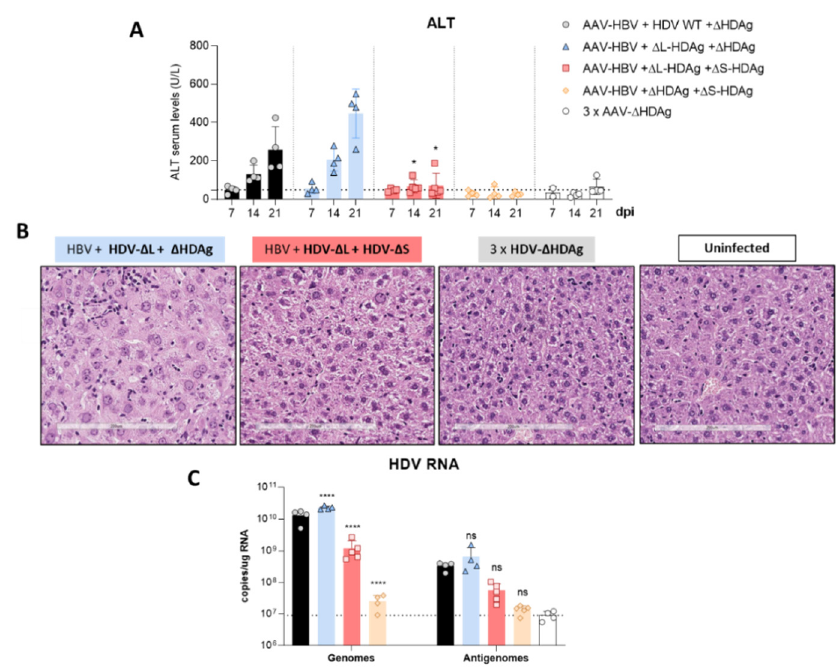
Figure 8. Expression of L-HDAg at the beginning of the HDV life cycle decreased liver damage and HDV replication. ( A ) Peripheral blood was collected weekly after the administration of the different combinations of AAV vectors, and ALT concentration in serum was measured. Individual data points and mean values ± standard deviation are plotted; significant differences between HBV/ Δ L-HDAg/ Δ HDAg and HBV/ Δ L-HDAg/ Δ S-HDAg groups at each time point were determined by a two-way ANOVA followed by Bonferroni multiple-comparison test. The dotted line represents the ALT ULN, 50 U/L. ( B ) Histological analysis of liver sections by H&E showed visible alterations in HBV/ ∆ L-HDAg/ ∆ HDAg that were not present in the HBV/ ∆ L-HDAg/ ∆ S-HDAg group. Normal histology was observed in the 3 × ∆ HDAg and uninfected groups. Scale bar: 200 µ m. ( C ) Total RNA was extracted from infected livers to quantify HDV genome and antigenome levels at 21 dpi by RT-qPCR. Significant differences between HBV/HDV WT/ ∆ HDAg and the rest of the groups were determined by a two-way ANOVA followed by Bonferroni multiple-comparison test. The dotted line represents the background. ns: no significant, * p < 0.05, **** p <